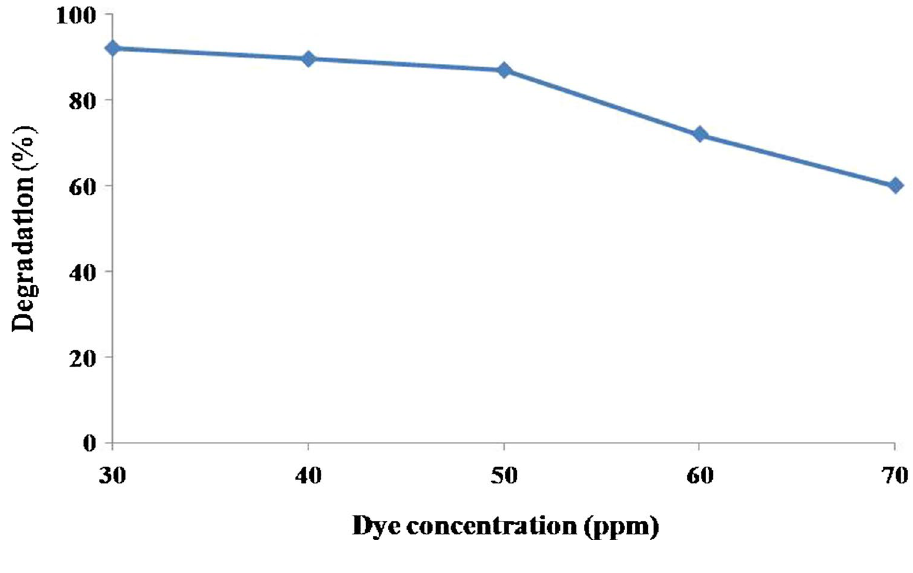
Fig. 11 %Degradation of MV at photodegraded at different pH by Co/cross-linked